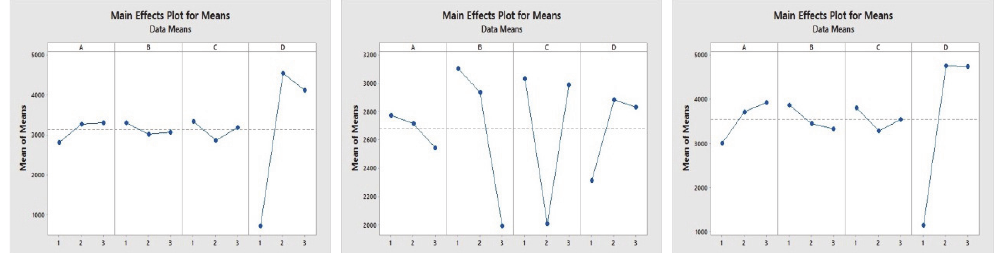
Fig. 9. The main effects plot of input parameters for small, medium and large scale problems while using the proposed hybrid TS-SA (left to